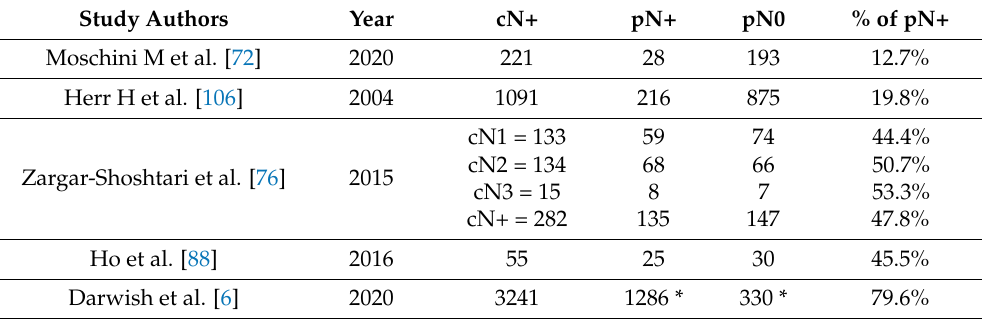
Figure 2. Superimposing of the anatomical areas of PLND during RC; the obturator fossa (red), external iliac vessels (yellow), internal iliac vessels (green), common iliac vessels (pink), and the presacral area (blue). Table 3. The comparison of studies presenting the percentage of pN+ in cN+